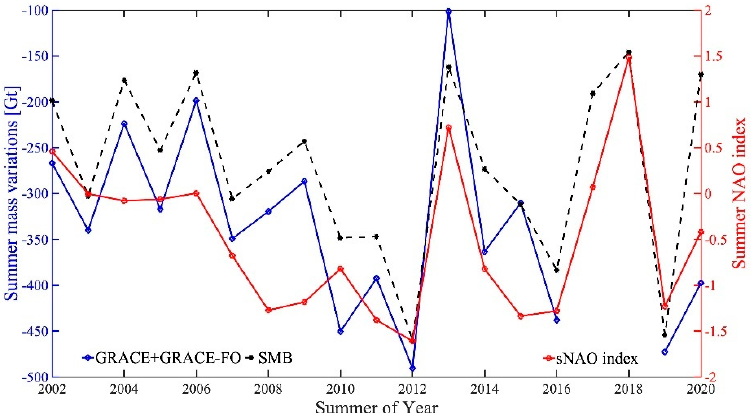
Figure 9. Summer mass change (blue line with rhombus) observed by GRACE/GRACE-FO and summer SMB (black line with asterisk) of the GrIS and summer NAO (sNAO) index (red line with circle).